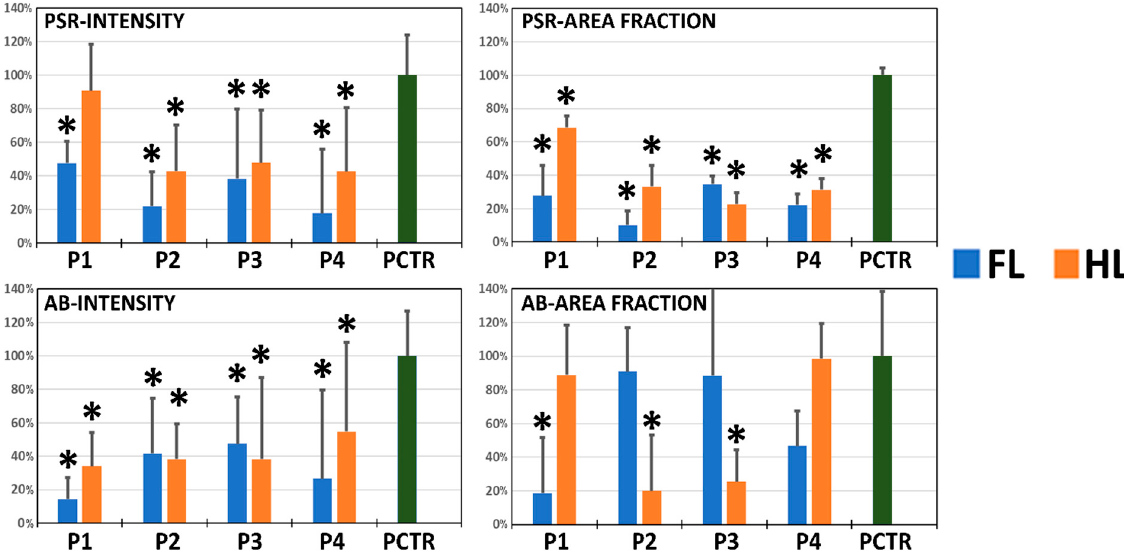
Figure 4. Quantitative analysis of the picrosirius red (PSR) and alcian blue (AB) staining intensity and area fraction of decellularized limbi (DLs). Four decellularization protocols (P1 to P4) were applied to the full ‐ thickness limbus (FL, blue bars) and the half ‐ thickness limbus (HL, orange bars). Results are shown as average values normalized with respect to the native porcine limbus used as control (PCTR, green bars), which is considered as 100%, with error bars corresponding to the standard deviations. Asterisks (*) represent statistically significant differences with the native porcine limbus used as control ( p < 0.05).